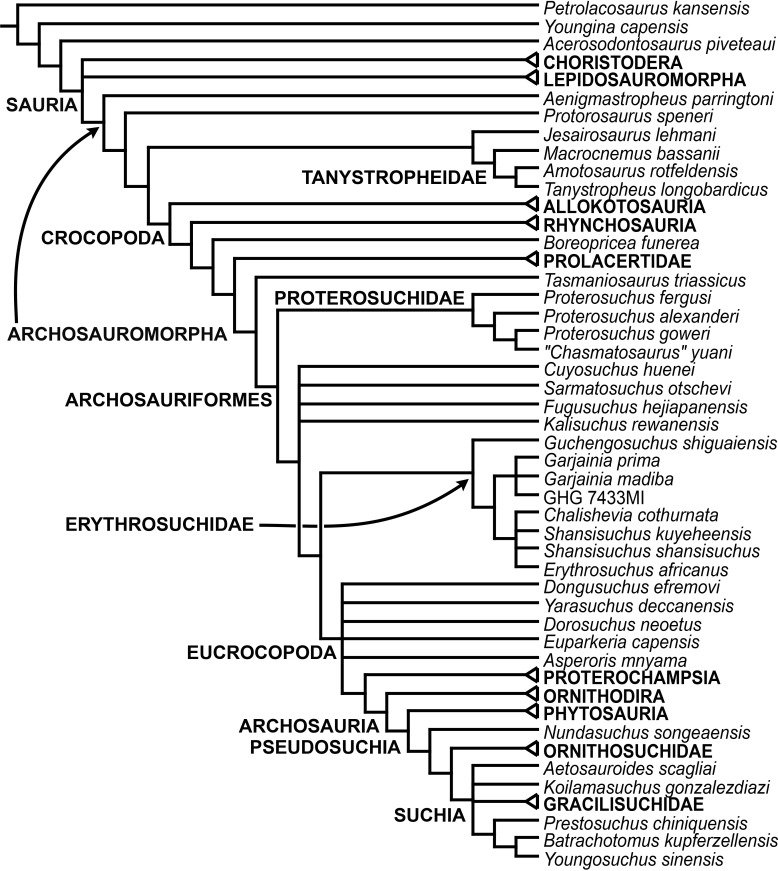
Third strict reduced consensus tree recovered from analyses 1 and 2.Some clades have been condensed into suprageneric terminals to simplify the figure and their internal relationships are the same as in previous figures.